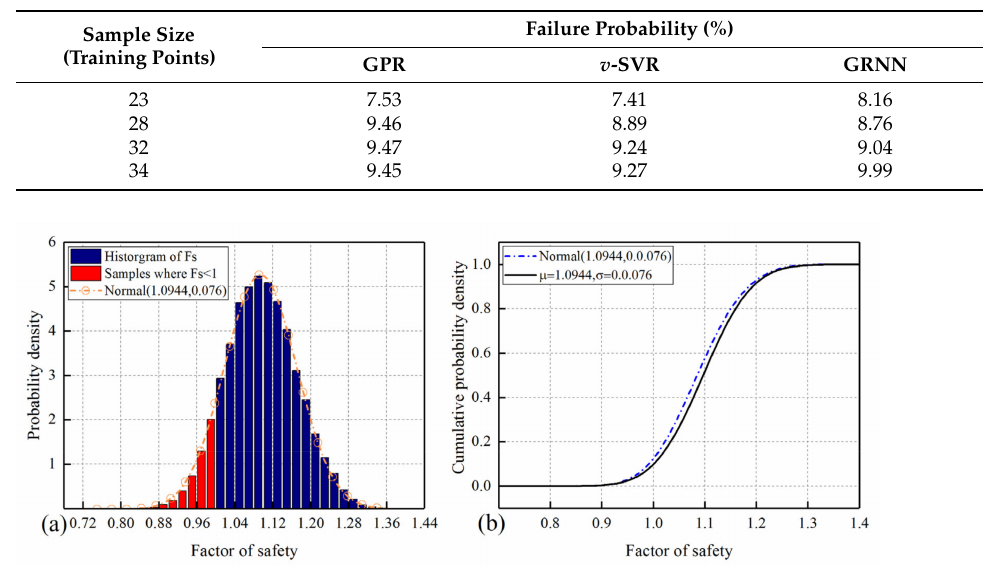
Figure 15. Results of MCS with 5 × 10 4 samples for Case 2: ( a ) Histogram and normal fit for the obtained factor of safety with the assumed normal distribution of random variables; ( b ) probability density distribution for the obtained factor of